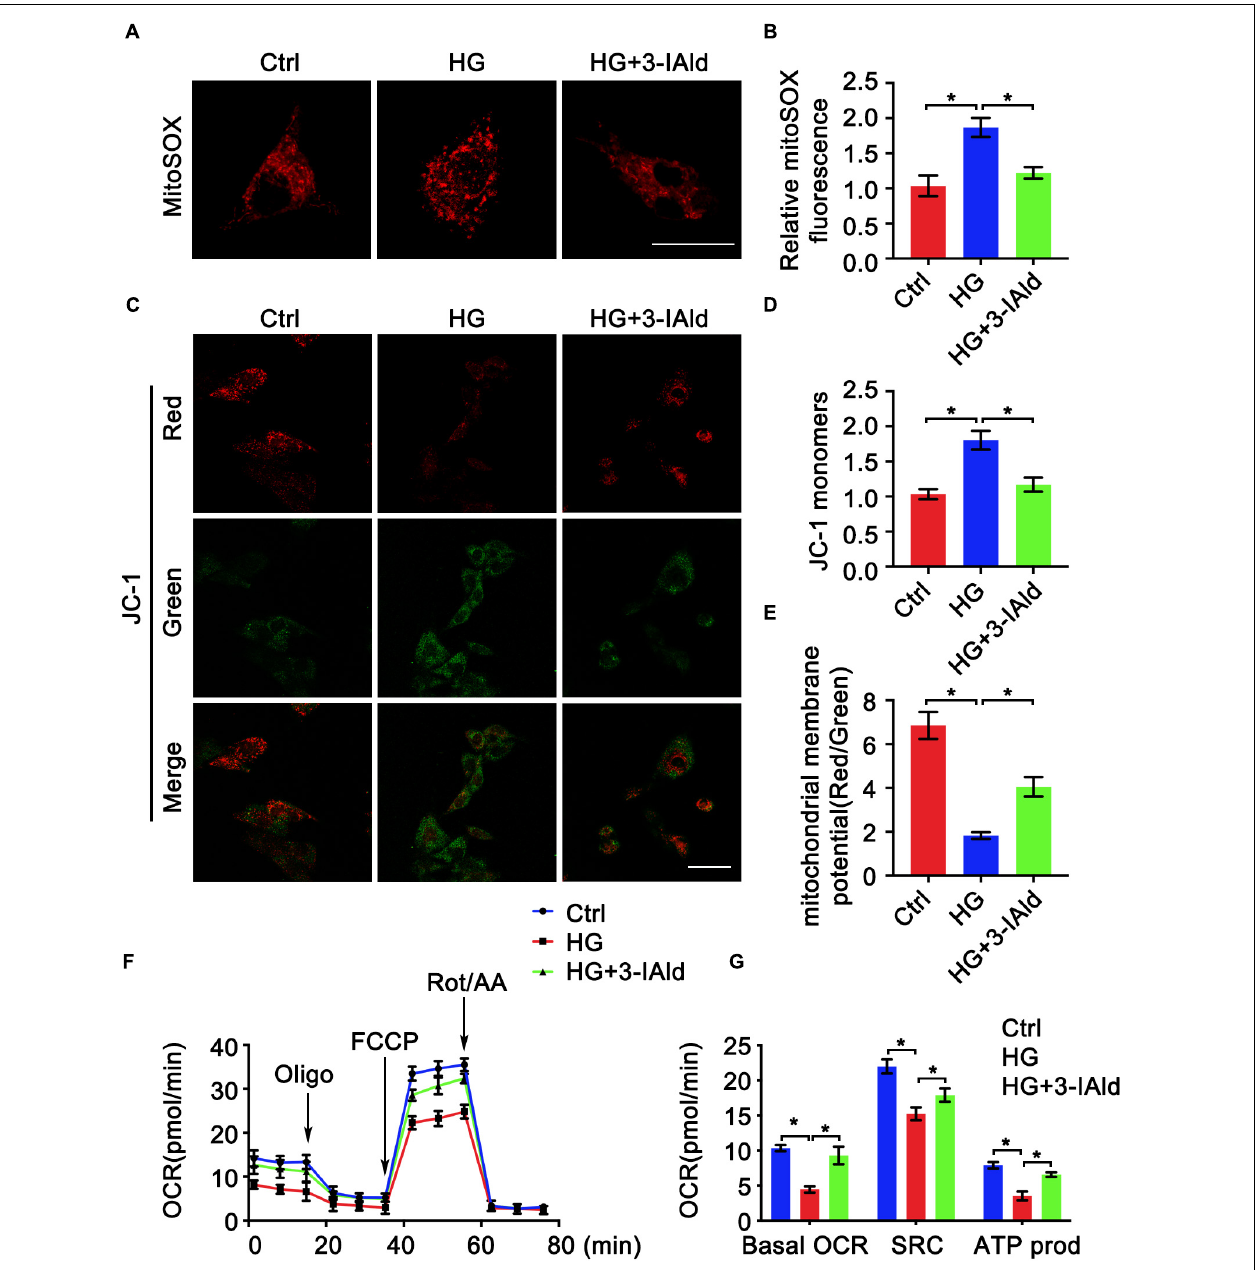
FIGURE 5 | 3-IAld attenuates HG-induced mitochondrial dysfunction in ECs. (A) MitoSOX staining in HUVECs in the control, HG and HG + 3-IAId groups, scale bar: 25 µ m. (B) Quantification of relative MitoSOX fluorescence; n = 6 for each group. (C) JC-1 staining in HUVECs in the control, HG and HG + 3-IAId groups; scale bar: 50 µ m. (D,E) Quantification of relative JC-1 monomers and mitochondrial member potential; n = 6 for each group. (F) Oxygen consumption rates (OCRs) in HUVECs in the control, HG and HG + 3-IAId groups before and after sequential injection of oligomycin, FCCP and a mixture of rotenone/antimycin A, as determined by a Seahorse XF96 Analyzer. (G) Corresponding calculated parameters of mitochondrial respiration; n = 6 for each group. Data are presented as the mean ± SEM. * P <